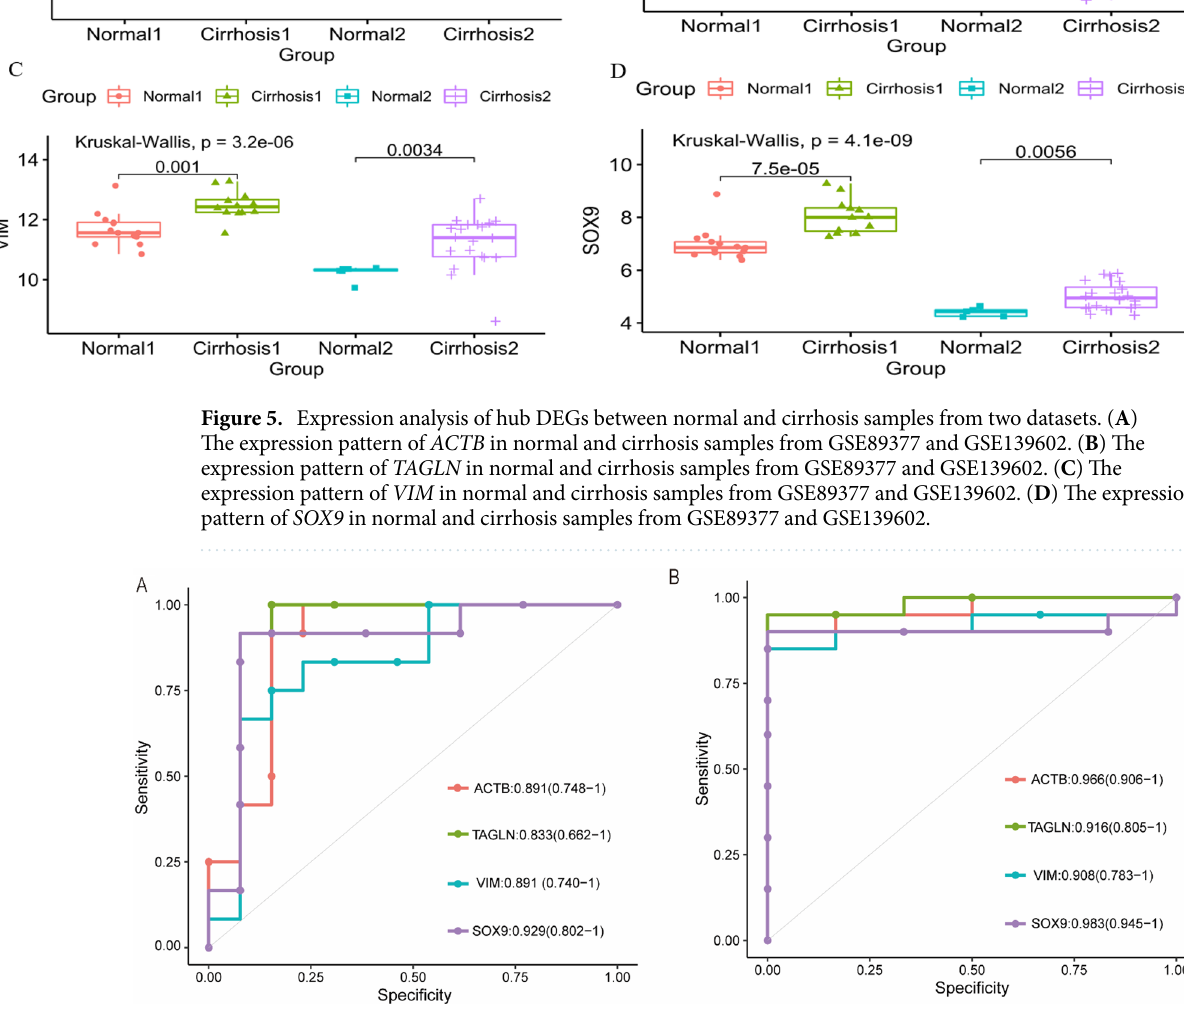
degradation to alleviate fibrosis in rodent models 40,41 . Activated liver-associated NK cells may be antifibrogenic